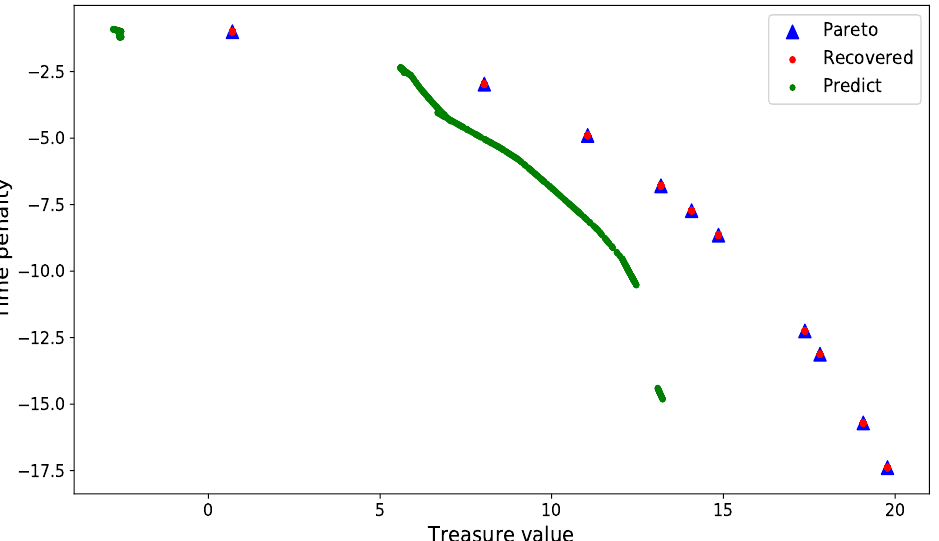
Figure 5. Coverage ratio and adaptation error of ENDs. The blue triangles represent the theoretical optimal frontier; the red dots represent the set of solutions found by the agent; the green dots represent the control frontier retrieved under the specified preference vector.